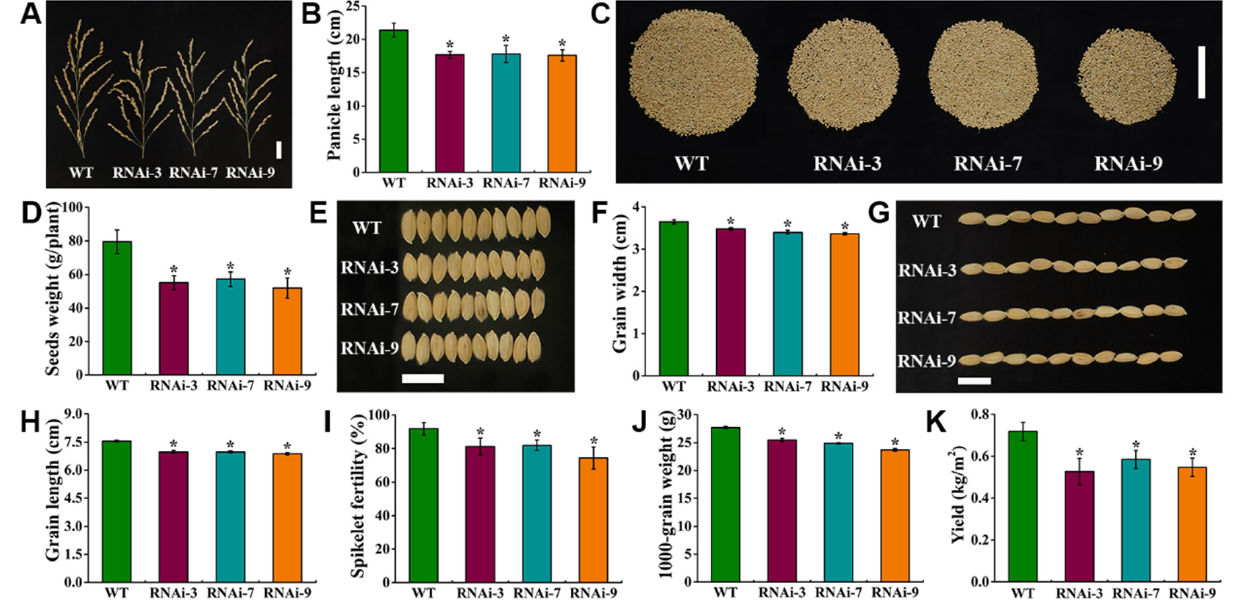
Figure 7. OsTMN11 RNAi lines inhibited panicle elongation and seed development of rice, resulting in decreased rice yield. Rice was grown to maturity under natural conditions for two consecutive years, with the statistics for the second year shown. ( A ) Phenotypes of panicles (Bars = 3 cm). ( B ) Panicle length. ( C ) Phenotype analysis of yield per plant (Bar = 10 cm). ( D ) Seed weight per plant. ( E , G ) Phenotypes of ten grains (Bar = 1 cm). ( F ) The ten-grain width. ( H ) The ten-grain length. ( I ) Spikelet fertility per panicle. ( J ) 1000-grain weight. ( K ) Seed yield per square meter. Data represent the means of three biological replicates. The data were tested by Tukey’s test, and the asterisk indicated that there was a significant difference between WT and RNAi lines ( p < 0.05).